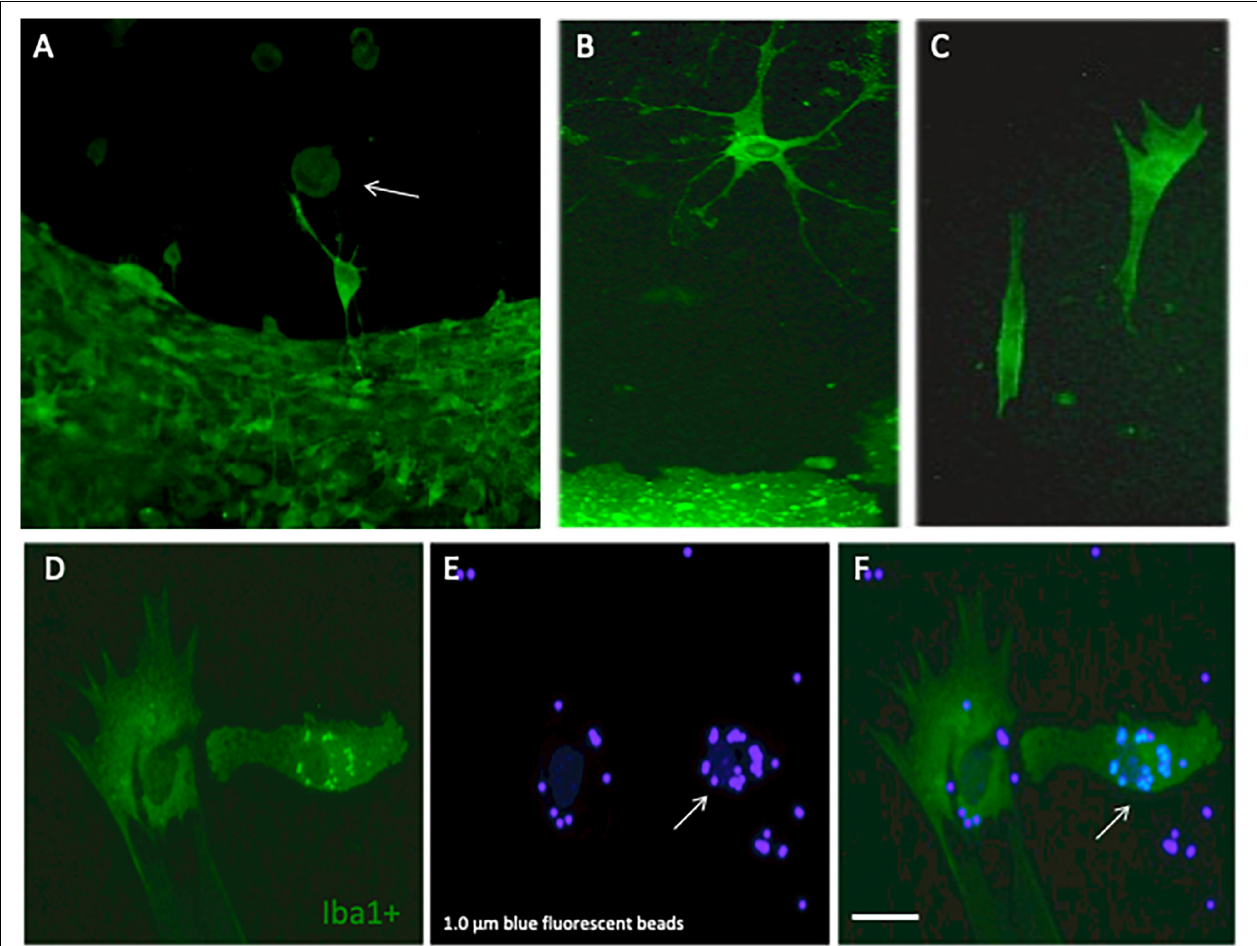
FIGURE 3 | Differentiation and phagocytosis of migrated microglia. Cortex brain slices were cultured on collagen microcontact prints ( µ CP) loaded with monocyte-chemoattractant protein-1 (MCP-1) for 3 weeks and then fixed and stained for the microglial marker Iba1 (stained with Alexa-488, fluorescent green). Panel (A) shows several round ameboid microglia (arrow) migrating out of the slice and in panel (B) a highly ramified microglia with many processes is shown and panel (C) shows two elongated forms of microglia. In order to demonstrate that these microglia are capable of phagocyting beads, the slices were incubated with 1.0 µ m blue fluorescent beads. Panels (D–F) show that migrated Iba1+ green fluorescent microglia (D) indeed can incorporate the blue fluorescent beads [ (E,F) , arrow]. Scale bar in panel (F) = 75 µ m (A–F)